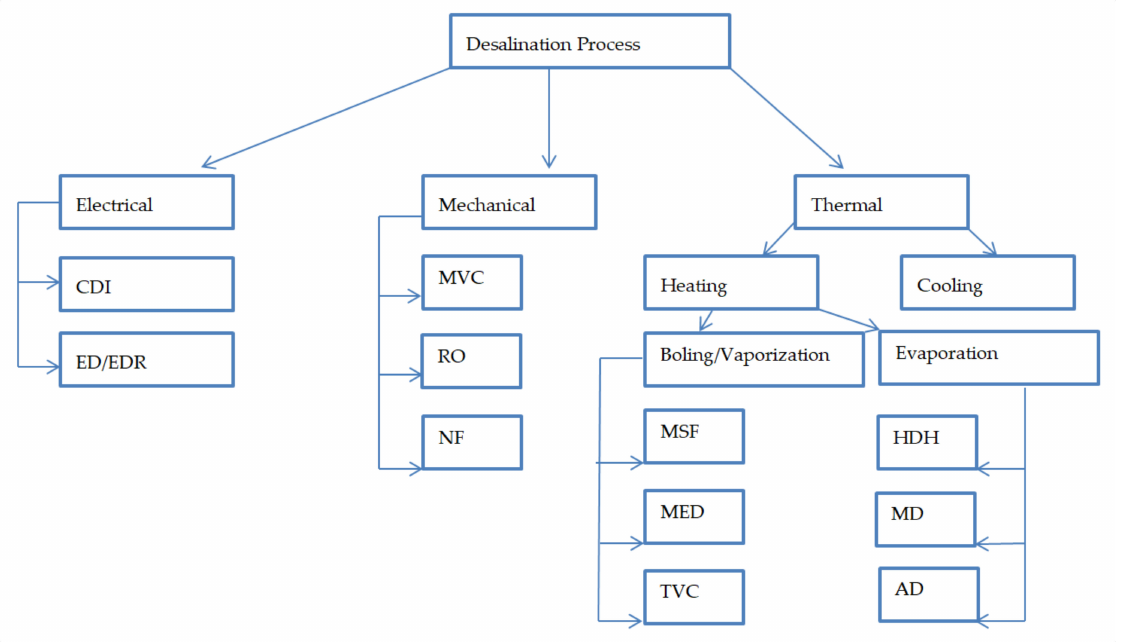
Figure 1. Division of desalination methods [9,10].